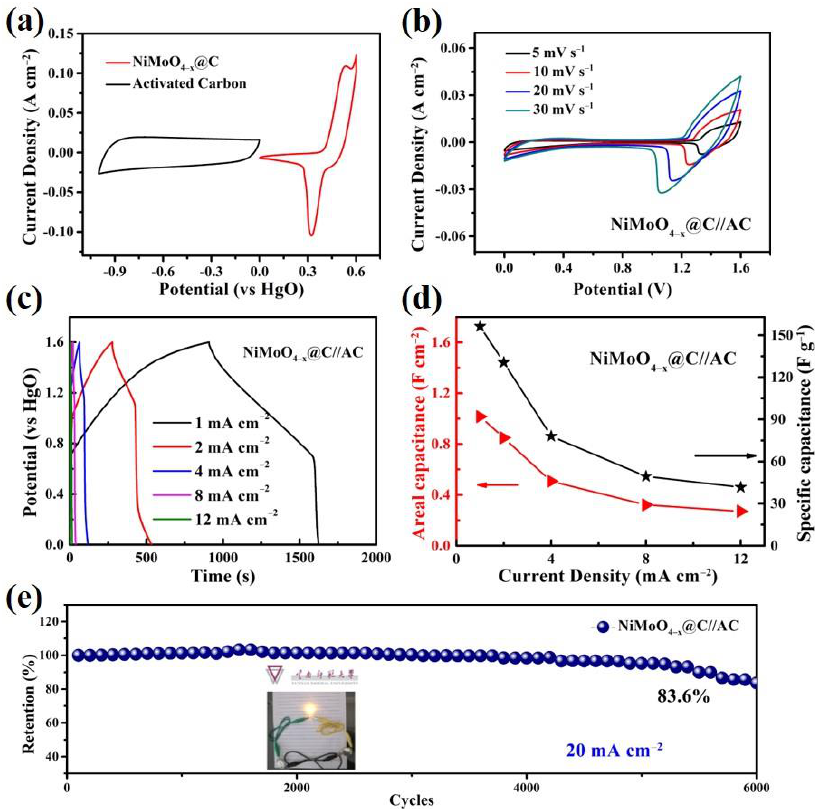
Figure 10. Electrochemical performance of the asymmetric NiMoO 4− x @C//AC supercapacitor. ( a ) CV curves of activated carbon (AC) and NiMoO 4− x @C electrodes from −1.0~0 V and 0~0.6 V, respectively, at 5 m V s −1 ; ( b ) CV curves; ( c ) GCD curves; ( d ) areal capacitance and specific capacitance; ( e ) cyclic stability of NiMoO 4− x @C//AC.